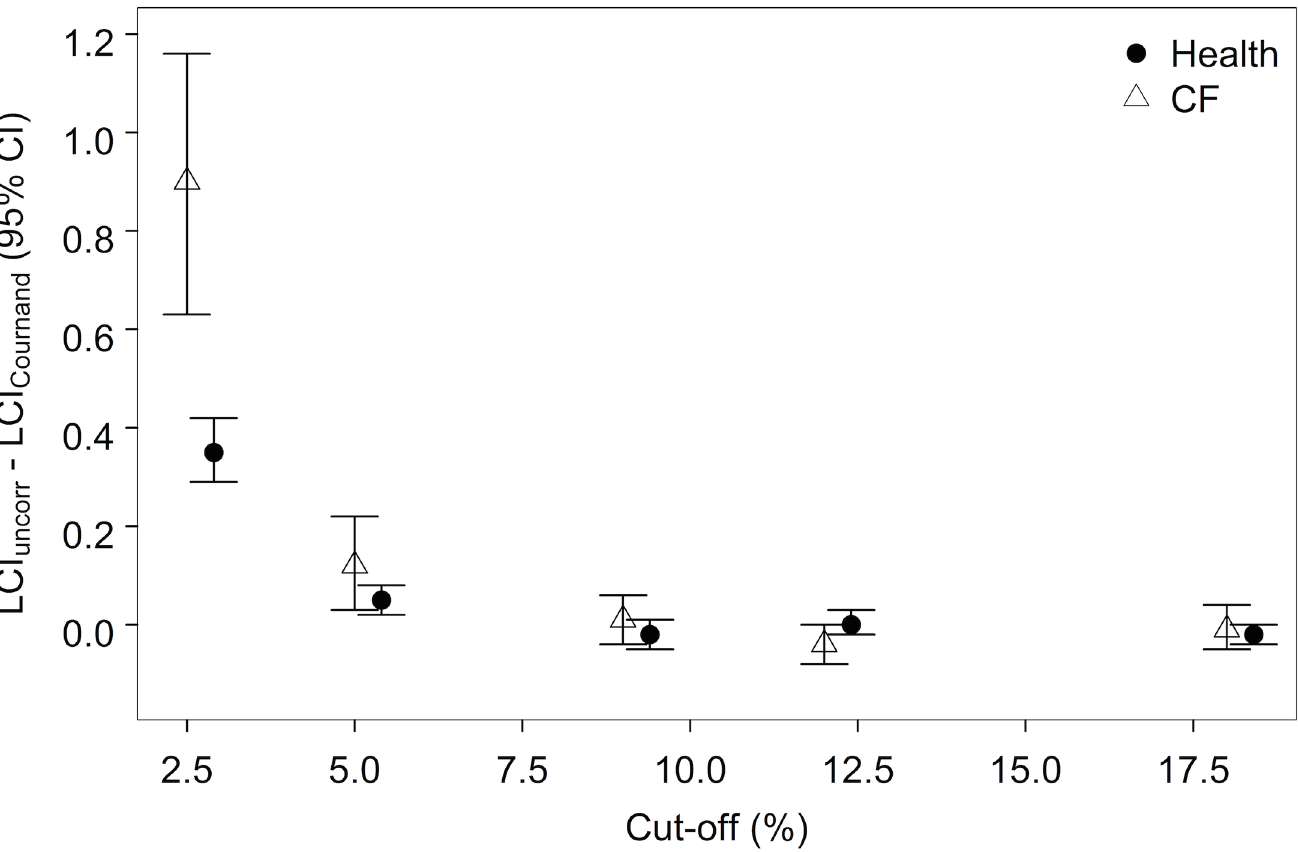
Fig 5. Within-subject difference between uncorrected LCI N2 and LCI N2 corrected for tissue N 2 excretion (LCI Cournand ) at different washout cut- offs. The difference was progressively smaller when calculatedat earliercut-offs of the washout in both health and CF.